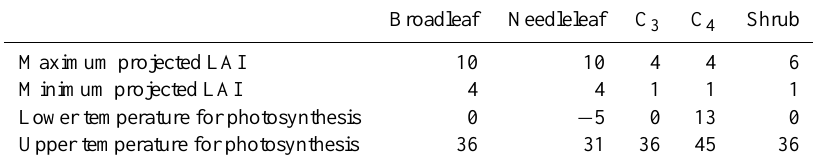
Table 1. Plant functional type parameters in TRIFFID. Temperatures are all in ◦ C; LAI is leaf area index. Broadleaf Needleleaf C 3 C 4 Shrub Maximum projected LAI 10 10 4 4 6 Minimum projected LAI 4 4 1 1 1 Lower temperature for photosynthesis 0 − 5 0 13 0 Upper temperature for photosynthesis